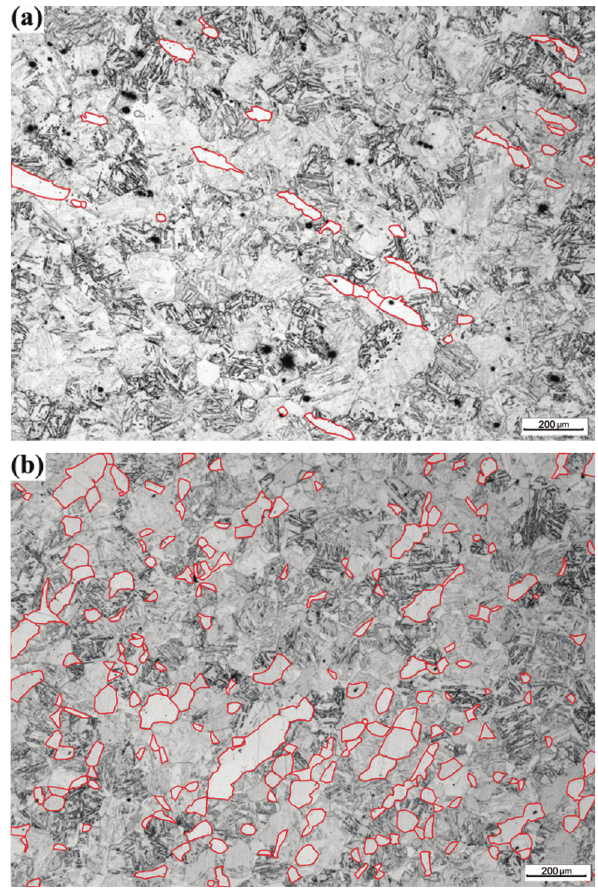
Figure 15: Microstructure of AISI 410 stainless steel at different temperatures: (a) T = 1,100°C and (b) T = 1,220°C (red-outlined areas indicate typical delta-ferrite grains).